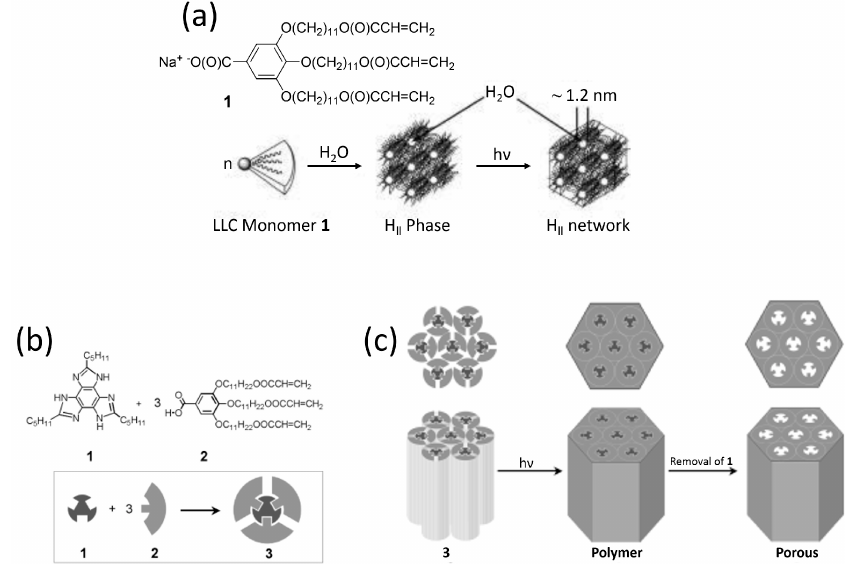
Figure 3 . The fabrication of nanoporous hexagonal liquid crystal networks. ( a ) Chemical structure of the lyotropic gallate moiety and stepwise formation of a porous LC network; ( b ) The